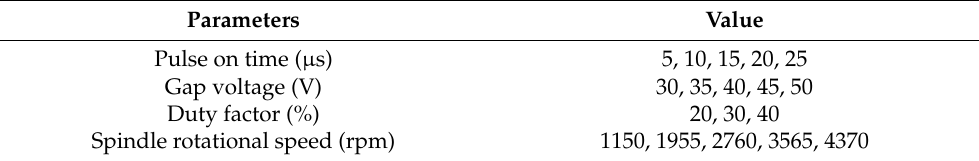
Table 3. Variable parameters and setting values of the µ -EDD